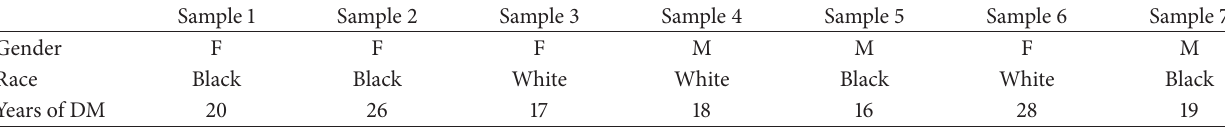
Table 1: Clinical characteristics of participants providing aqueous humor